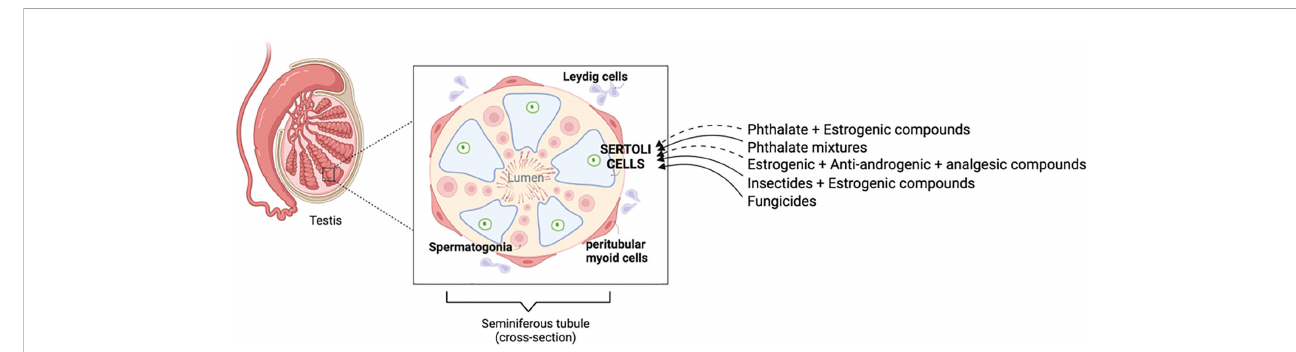
FIGURE 1 Toxicant mixtures targeting Sertoli cells in testis. The zoom-in illustrates various testicular cell types, including Leydig and peritubular myoid cells in the interstitium, and in the seminiferous tubules, Sertoli cells and germ cells, from spermatogonia to subsequent spermatogenic cells resulting in spermatozoa, which are released in the lumen. Sertoli cells play a vital role during male gonad development and throughout spermatogenesis in adulthood, acting as “ nurse cells ” of germ cells. Thus, assessing the impact of EDC and drug exposures on these cells is important. Some of the mixtures discussed in this review are highlighted here. A dashed arrow suggests indirect effects of exposure to toxicant mixtures on Sertoli cells, whereas a solid arrow suggests direct effects of exposure to toxicant mixtures on Sertoli